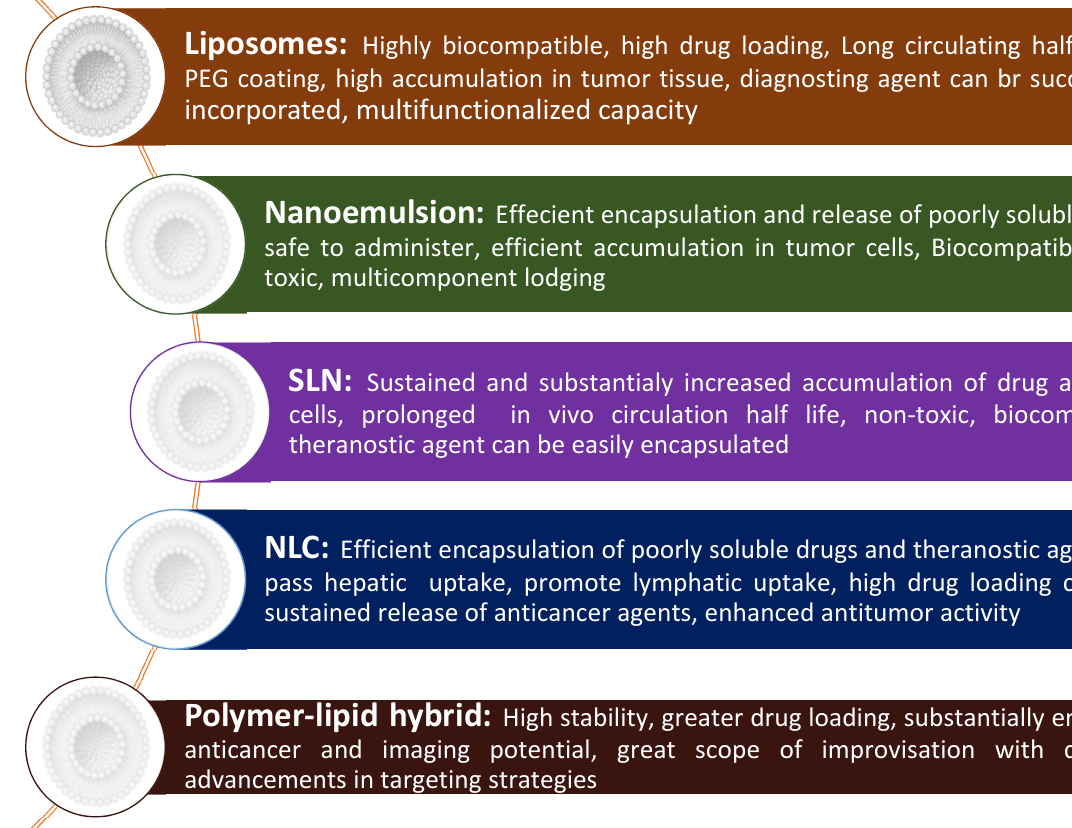
Figure 3. Potential advantages of different types of lipidic formulations in cancer theranostic.